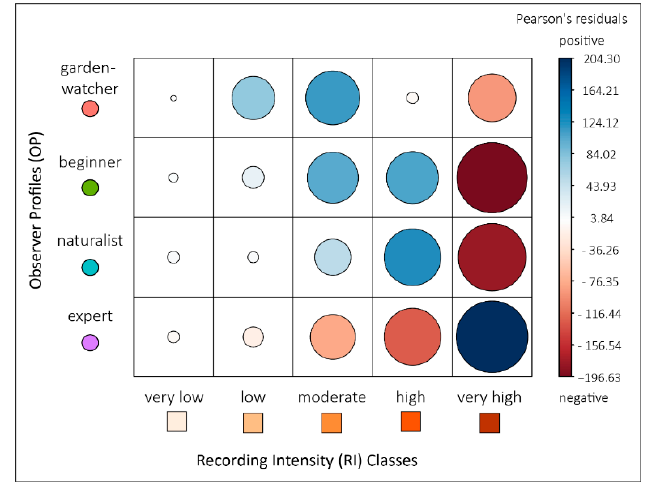
Figure 4. Relationships between observer profiles and recording intensity in terms of numbers of bird records. Matrix of residuals from the Pearson’s Chi-squared tests of association, using “corrplot” package in R. Blue indicates an over-representation, and red indicates an under-representation. Circle diameter is proportional to numbers of birds recorded for each observer profile/recording intensity class combination.